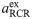
Effects on relay-cell spatial impulse-response function from mixed excitatory and inhibitory feedback.Top row: dependence on cortical feedback widths aRCRex and aRCRin with weights kept fixed: wRCRex=0.3 and wRCRin=-0.6. Bottom row: dependence on cortical feedback weights wRCRex and wRCRin with widths kept fixed: aRCRex=0.1, and aRCRin=0.9. All values are normalized with respect to the case where relay cells only receive feedforward excitation from retinal ganglion cells. The parameters in WG and KRG are kept fixed (see Table 1).